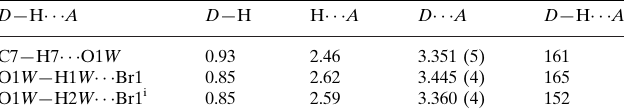
Hydrogen-bond geometry (A ˚ , (cid:4)